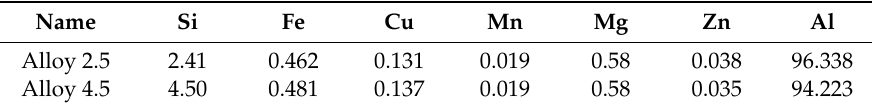
Table 1. Measured composition (wt %) of